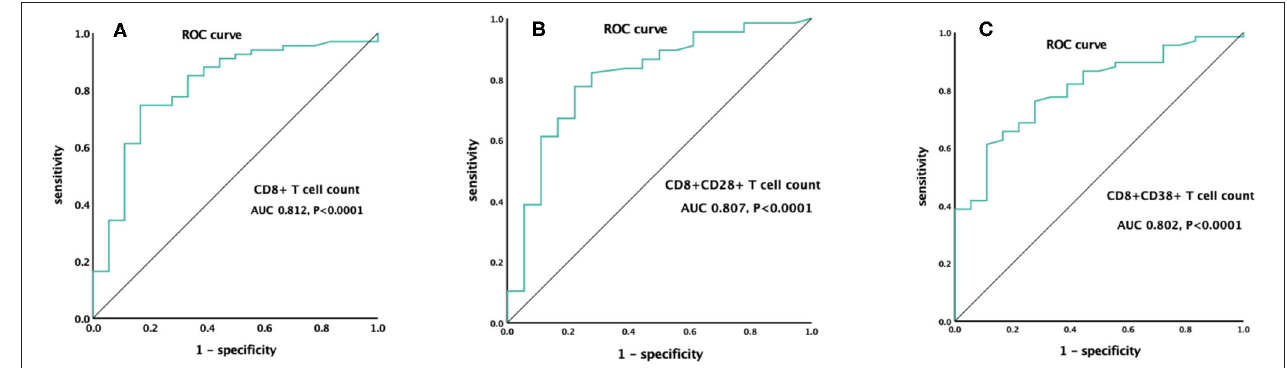
FIGURE 2 | ROC curve of CD8 + T cell count (A) , CD8 + CD28 + T cell count (B) , and CD8 + CD38 + T cell count (C) for the prediction of 28-day mortality.